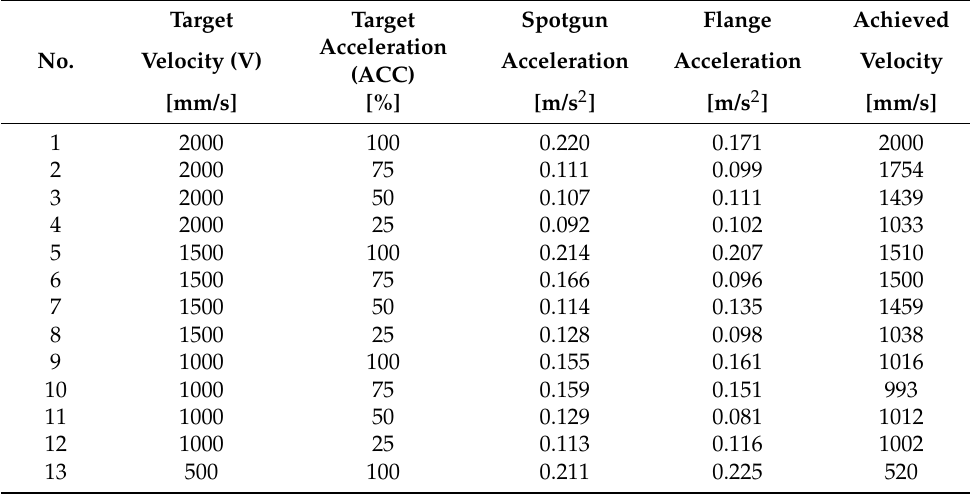
Table 1. Maximum tool and flange acceleration values for the set motion parameters after stopping at the process point.